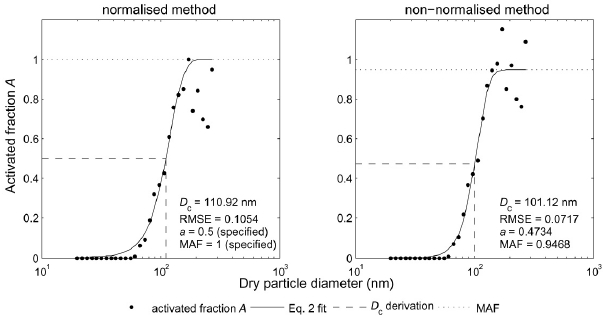
Fig. 2. A sample CCN efficiency spectrum measured on 24 June 2009 from 20:02:03 to 20:23:13UTC (Universal Time Coordinated) + 2, and two ways of determining D c . Left panel: nor- malised method; right panel: non-normalised method. Both panels show the calculated D c , a root mean square error (RMSE) of the fit, a and the maximum activated fraction MAF. Note, that in the normalised method a and MAF were assigned values of 0.5 and 1, respectively; in the non-normalised method these values were al- lowed to